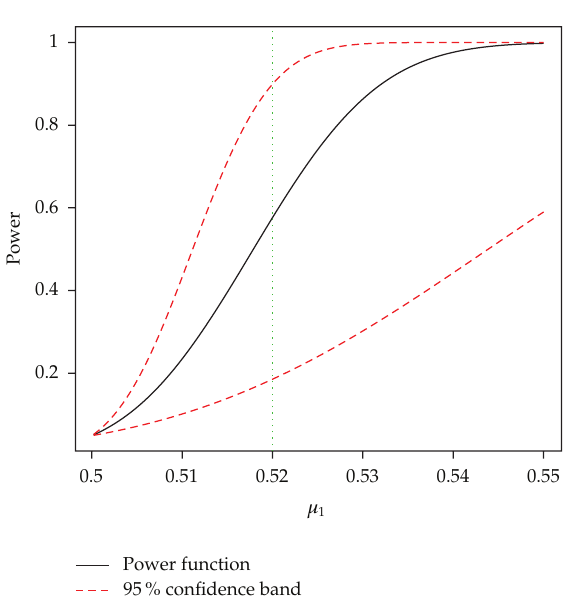
Figure 2: Power function and the 95% confidence